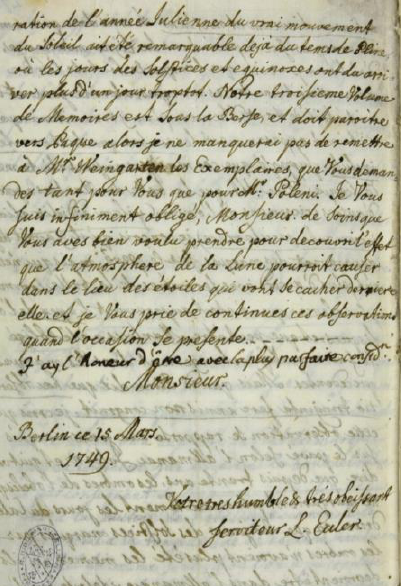
Figure 9: Euler to Marinoni 15.3.1749 , Original letter from Biblioteca Marucelliana in Florence, B, B._I.27._IV/22, cc.269- 270. Euler agrees with Marinoni on the intended use of the obelisk to determine the midday line. He also relies on the dimension of the shadow and the impossibility due to local conditions to display longer shadows than those at lunchtime on the winter solstice. They also agree on the function of the golden ball. Both astronomers explain the deviations due to the errors of the Julian calendar. 10